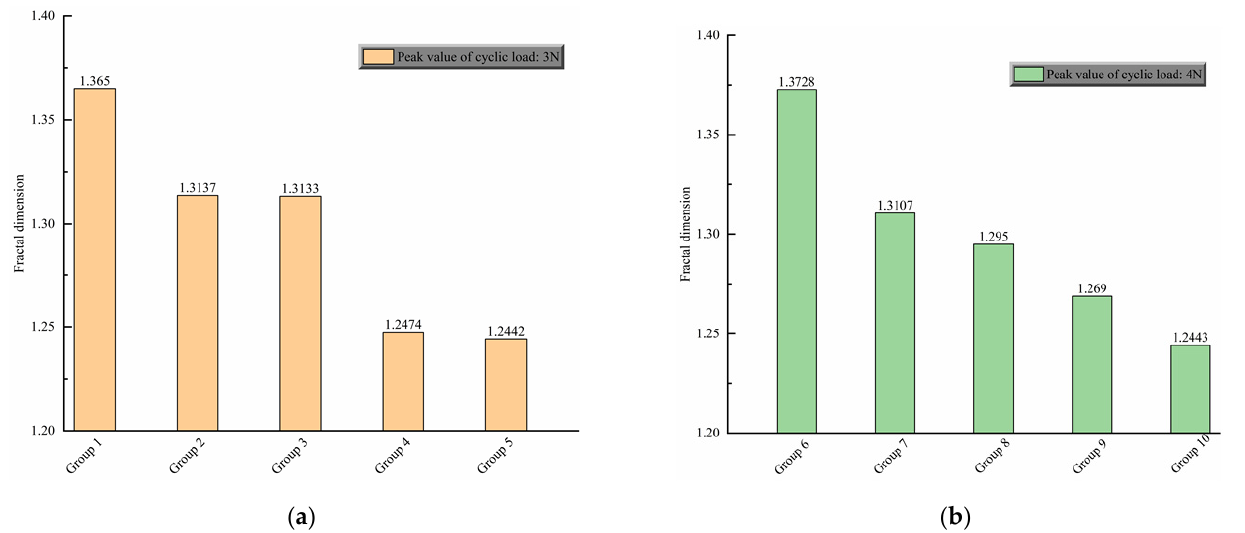
Figure 9. Fractal dimension of the curve of the relationship between the pile top displacement and cycle steps. ( a ) Peak value of cyclic load: 3 N. ( b ) Peak value of cyclic load: 4 N.